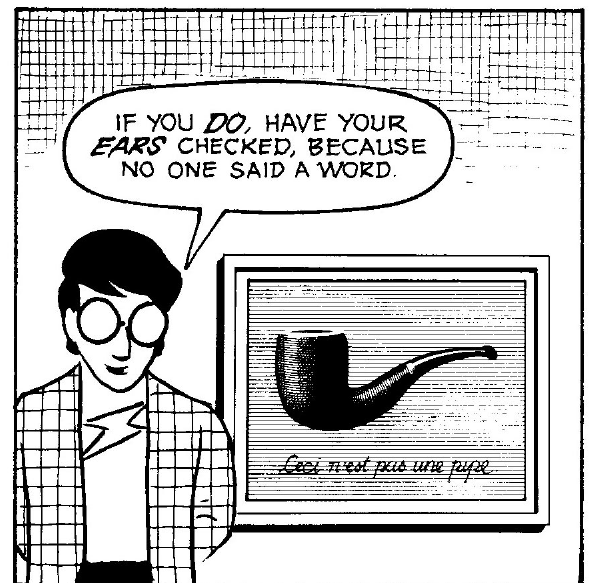
Fig. 5: McCloud, Understanding Comics (1993)